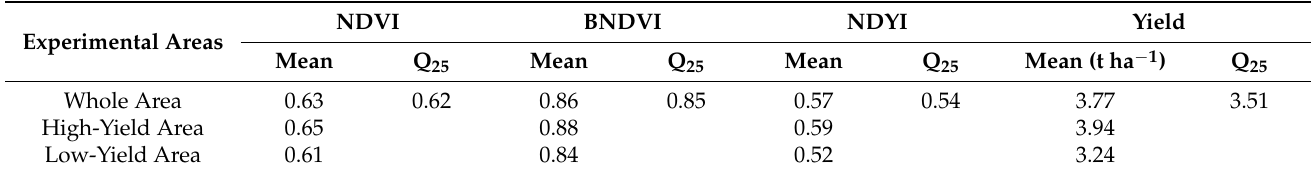
Table 6. Comparison of the mean values of VI and yields for the experiment (WHOLE AREA) and GREEN AREA and RED AREA